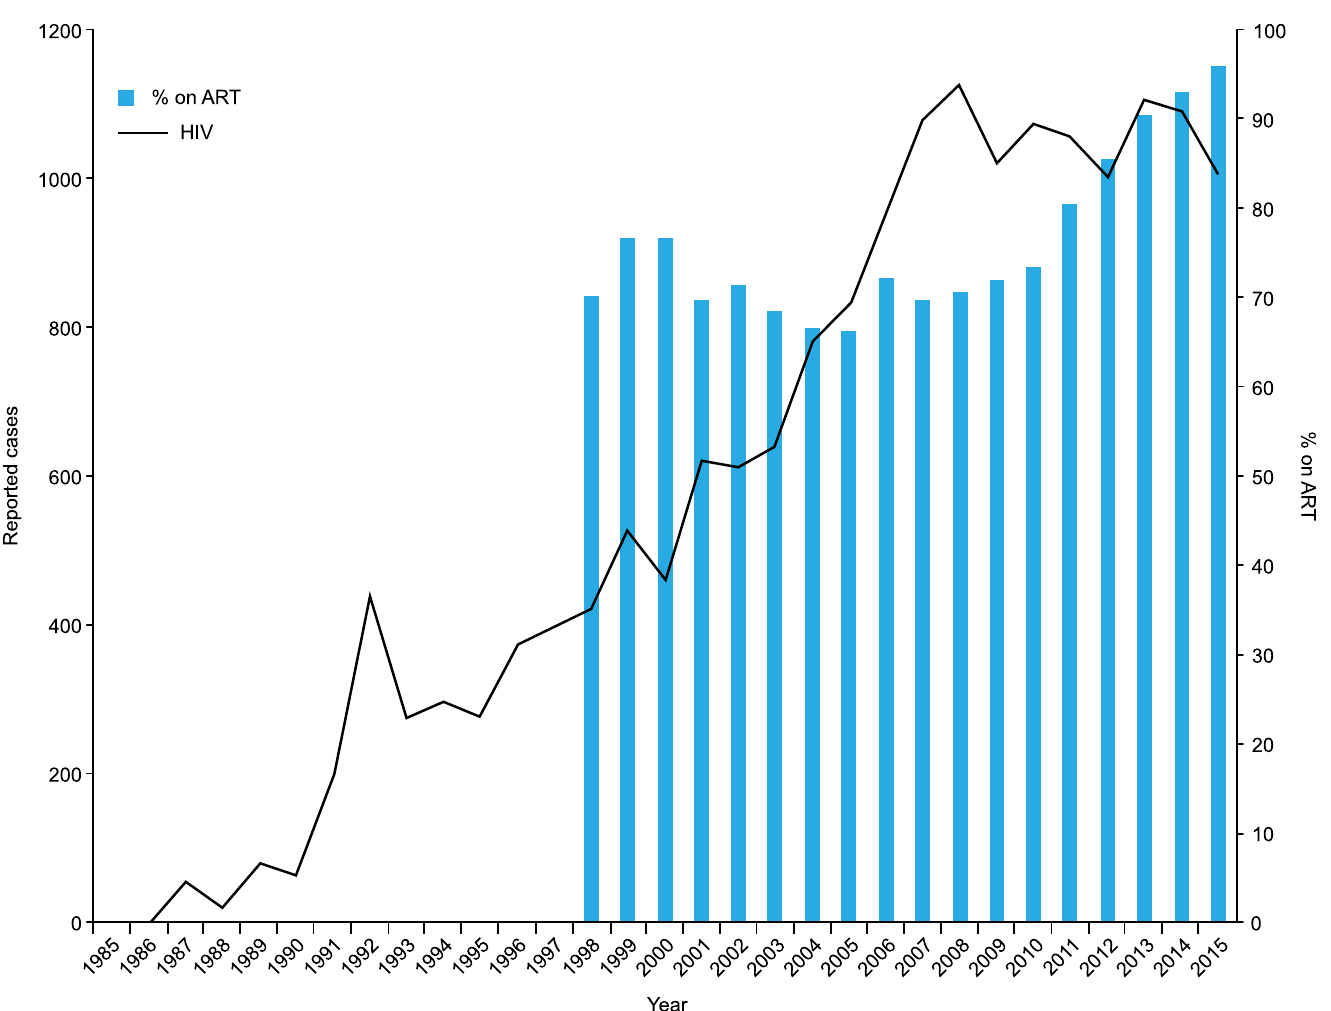
Fig 3. Annually reported new HIV infections and % on ART in an AIDS Core Hospital. Polygonal lines in black show the annuallyreportednew HIV infectionsin Japan. Columns in blue show the percent of patients on ART in the IMSUT Hospital.